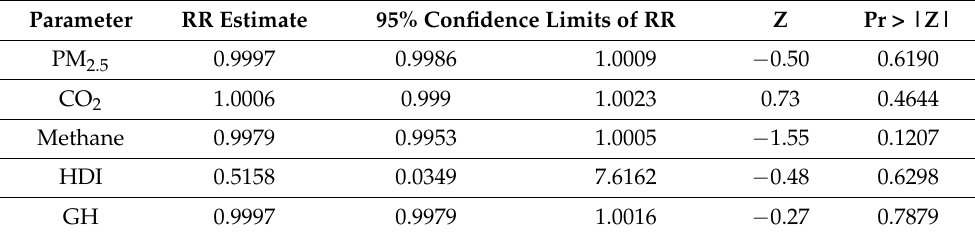
Table 5. Multiple regression results considering all selected air pollutants controlling for yearly trend. Variable RR Estimate 95% Confidence Limits of RR Z Pr > |Z| Year 1.0290 1.0044 1.0541 2.31 0.0206 PM 2.5 0.9999 0.9981 1.0018 − 0.07 0.9408 CO 2 1.0000 0.9984 1.0016 − 0.01 0.9906 Methane 0.9969 0.3160 − 1.14 GH 1.0005 0.9990 1.0020 0.61